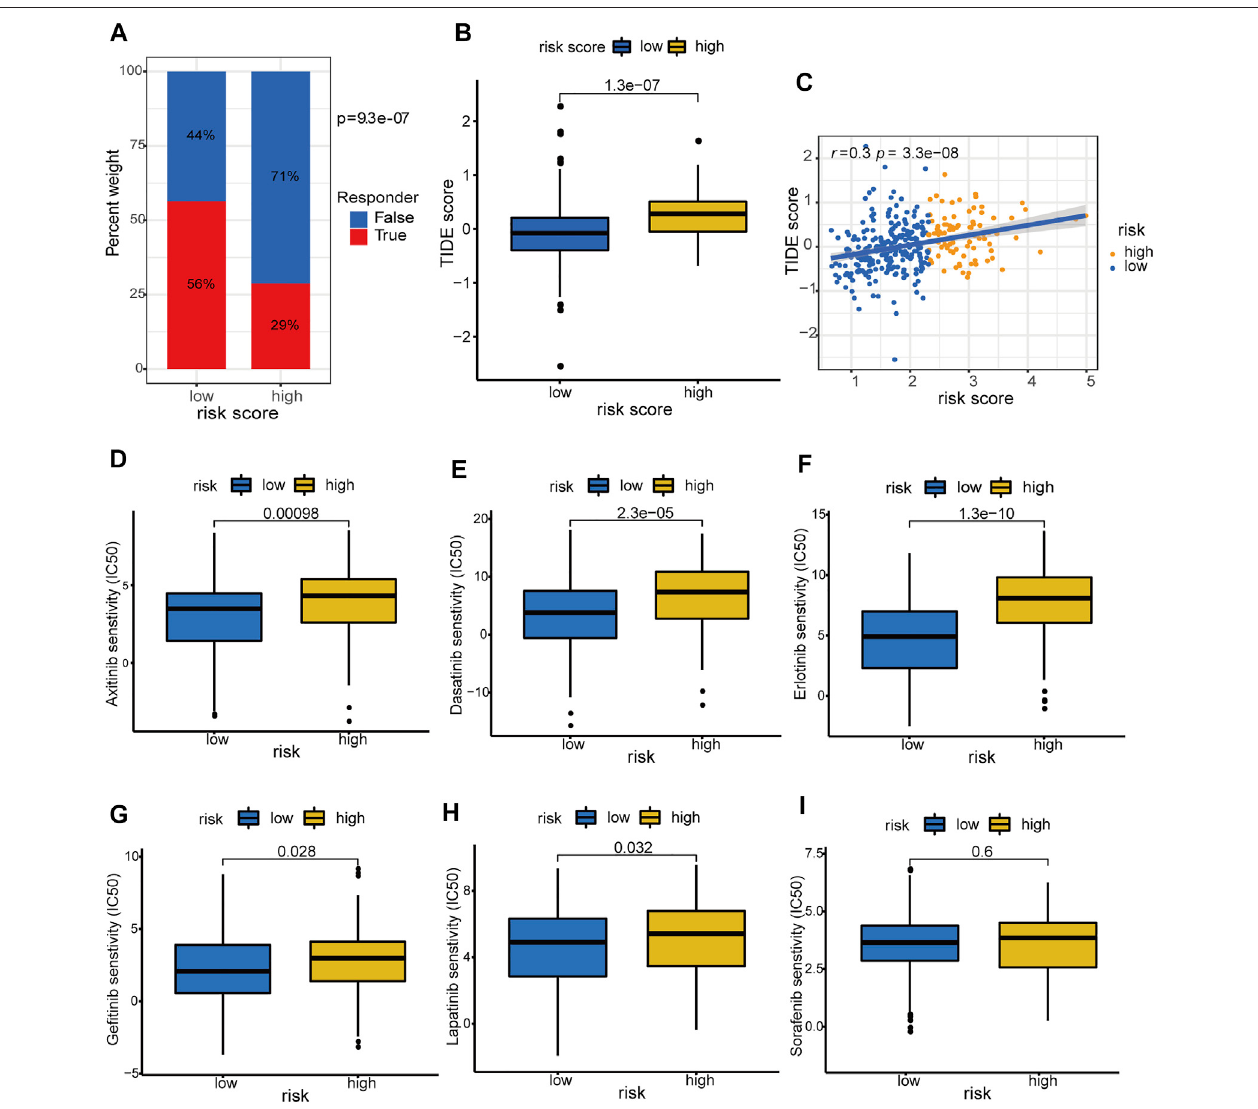
FIGURE13| Predictionofimmunotherapyresponseand targeted-drug sensitivity. (A) Comparison ofpredictedimmunotherapeuticresponder proportion and (B) TIDE score between the high- and low-risk groups. (C) Correlation between hypoxia-related risk score and TIDE score in TCGA-LIHC cohort. Comparisons of the IC 50 valuesbetweenthehigh-andlow-riskgroupsforAxitinib (D) ,Dasatinib (E) ,Erlotinib (F) ,Ge fi tinib (G) ,Lapatinib (H) ,andSorafenib (I) ,respectively.TIDE:TumorImmune Dysfunction and Exclusion. IC 50 : half-maximal inhibitory